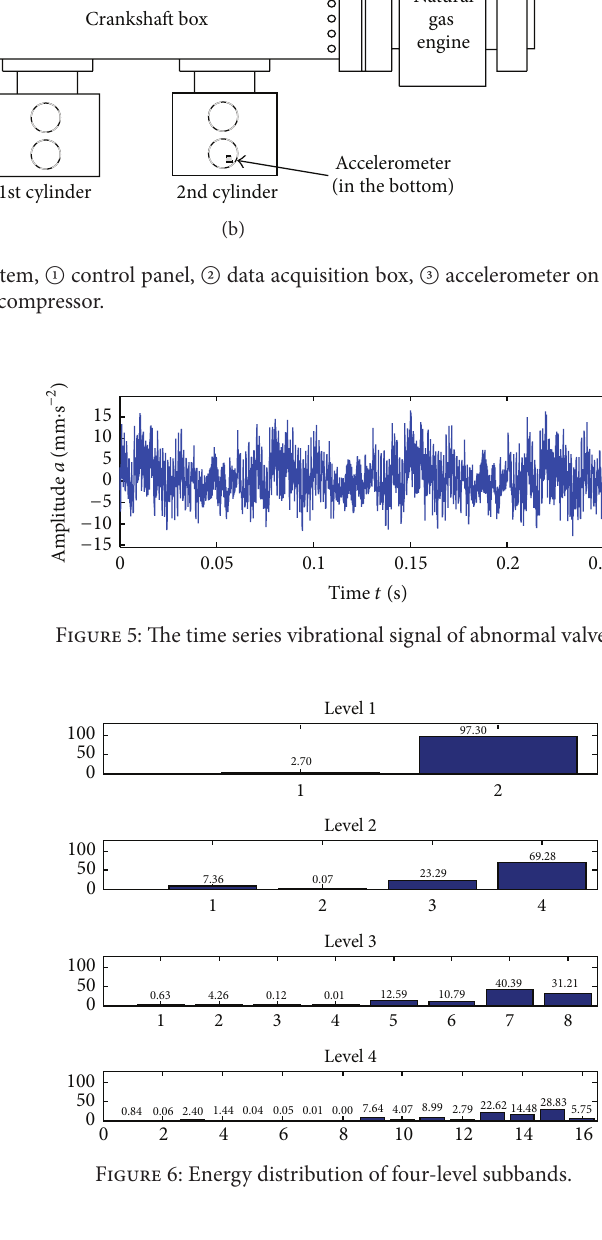
where 𝑁 = 𝑁 󸀠 = 4 . From (11)–(13), the prediction operator P and the update operator U can be obtained as P = [−0.0625, 0.5625, 0.5625, −0.0625] and U = [−0.0313, 0.2813, 0.2813, −0.0313] . Finally, the 16 subbands of the fourth level are obtained and the energy distribution of